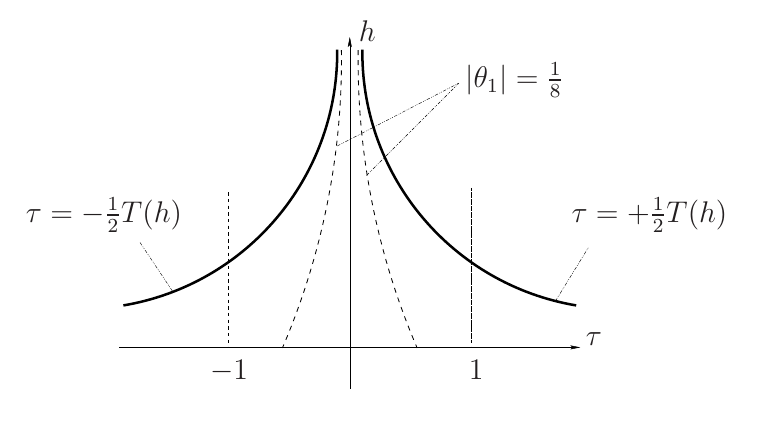
Fig. 3 The domain